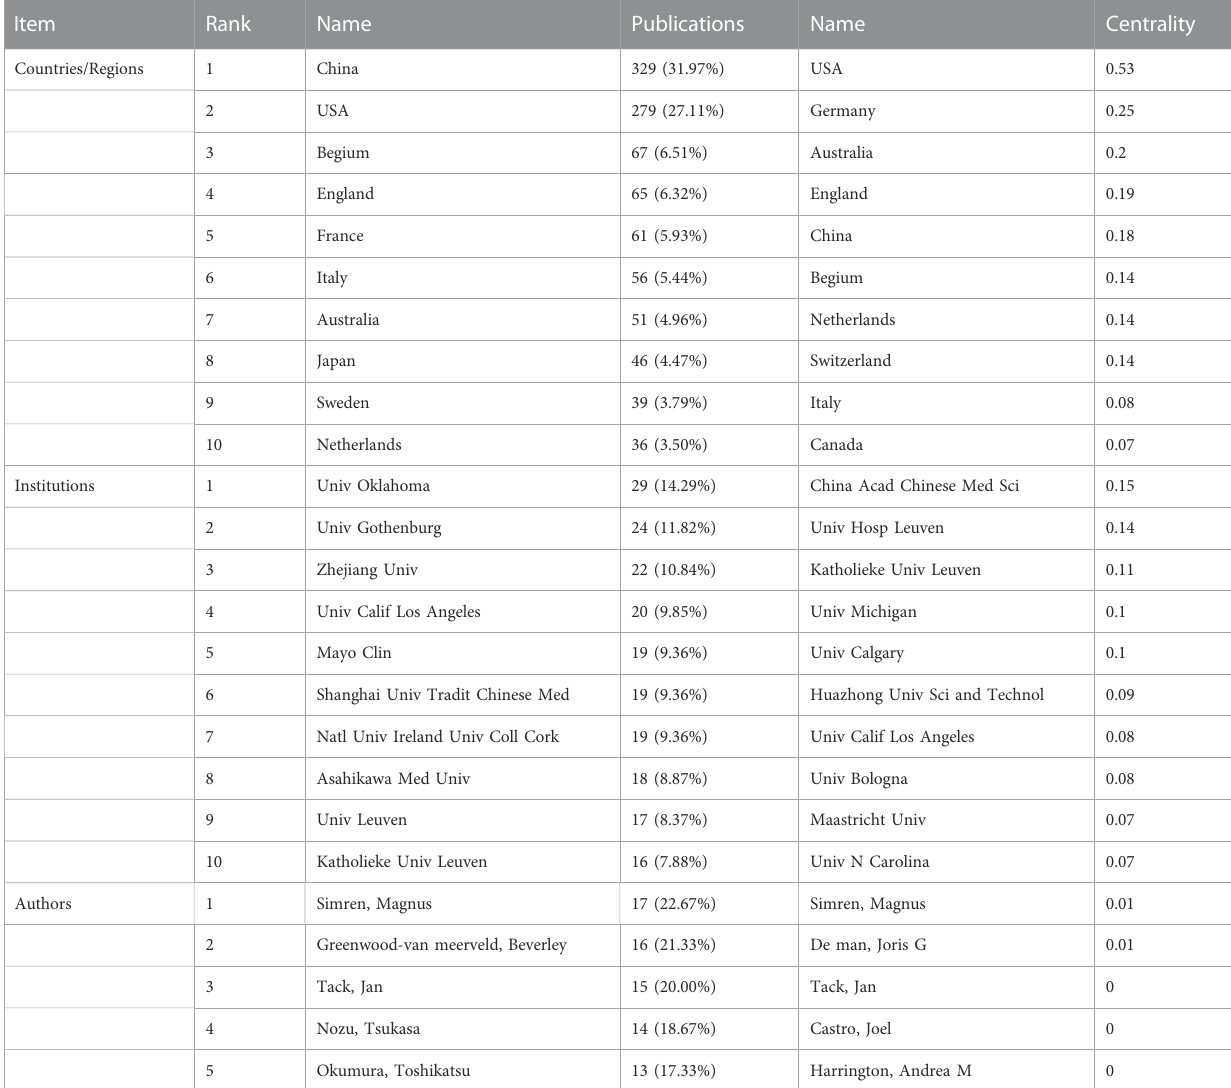
TABLE 1 Countries/regions, institutions, and authors ranked by publications and centrality. Item Rank Name Publications Name